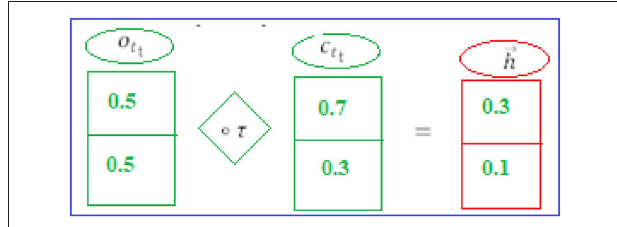
FIGURE 4 | 1st hidden layer.